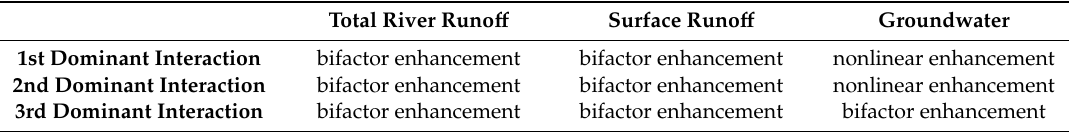
Table 9. Interaction modes of the factors on runo ff in the middle elevation hill region.